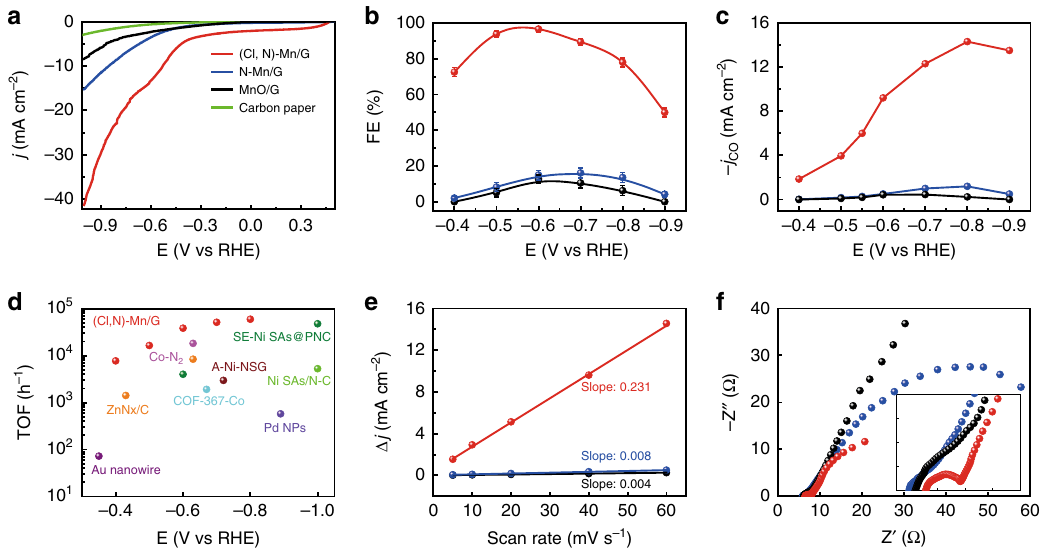
Fig. 3 Electrochemical CO 2 RR performance on (Cl, N)-Mn/G catalyst and control samples of N-Mn/G, MnO/G and carbon paper. a LSV curves of different catalysts (in a CO 2 -saturated 0.5 M KHCO 3 solution, scanning rate: 10 mV s − 1 ). b FE CO at various applied potentials. c Potential-dependent CO partial current density. d TOF of (Cl, N)-Mn/G catalyst compared with those of other CO 2 to CO reduction catalysts in the Supplementary Table 5 7 – 13,29,31-41 . e Charging current density differences plotted against scan rates. f EIS spectra. The inset shows the enlarged Nyquist plots for high frequency region. All data in b are presented as mean ±